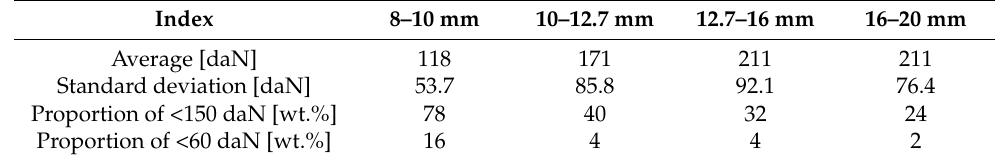
Table 6. Numerical values of the CCS